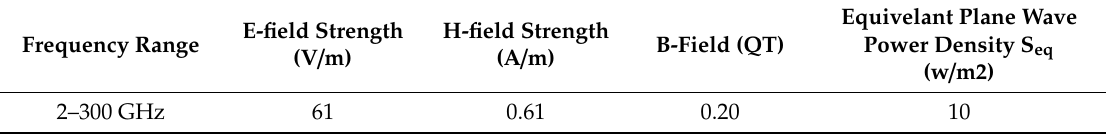
Table A2. ICNIRP reference levels for public